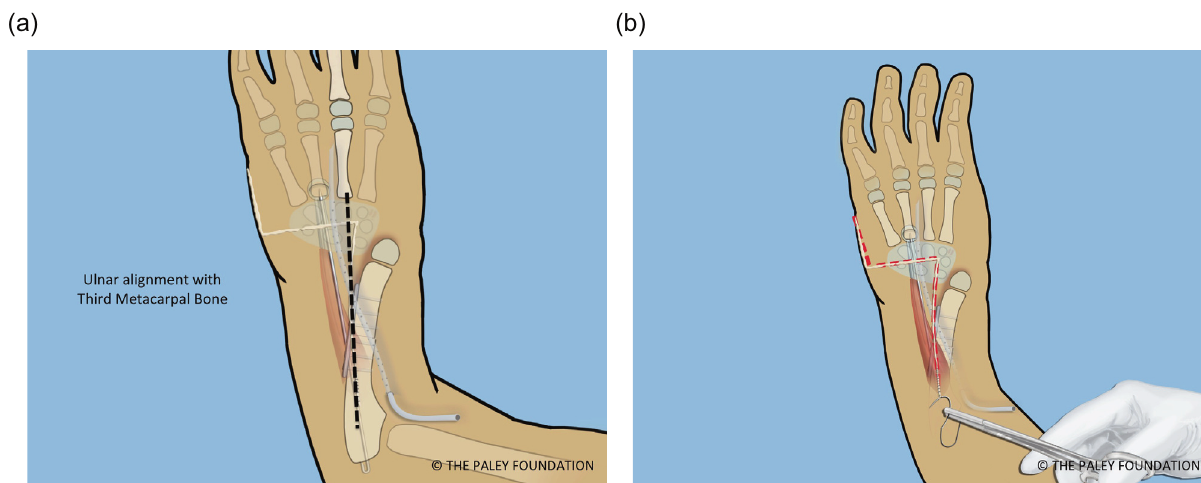
Figure 24. The proximal ulna is parallel and in line with the third metacarpal (a). The Z-shaped incision is closed over a drain (b). It is important to complete a volar fasciotomy before closing to allow for swelling without the risk of compartment